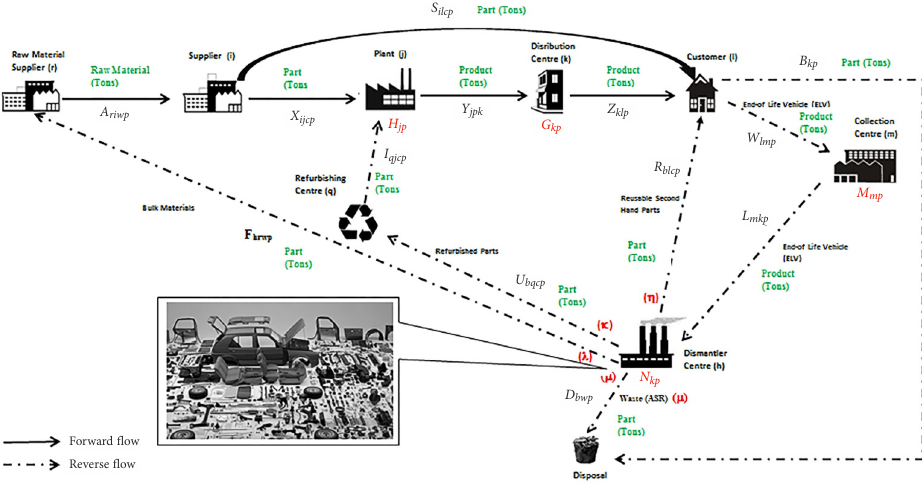
Fig. 1. Designed FSC, RSC and CLSC Network Design